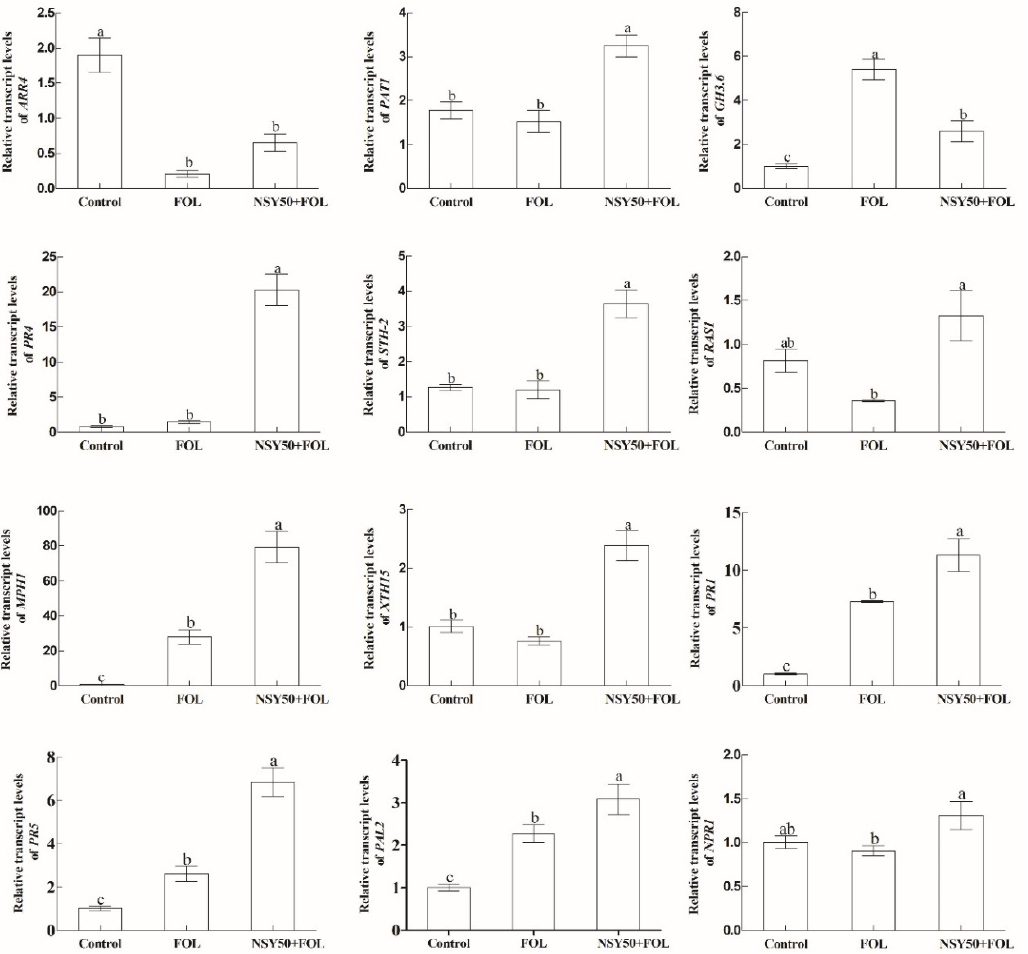
Figure 3. Effects of NSY50 on the relative transcript levels of 12 genes in tomato. Different letters (a, b, and c) indicate statistically significant differences at p = 0.05